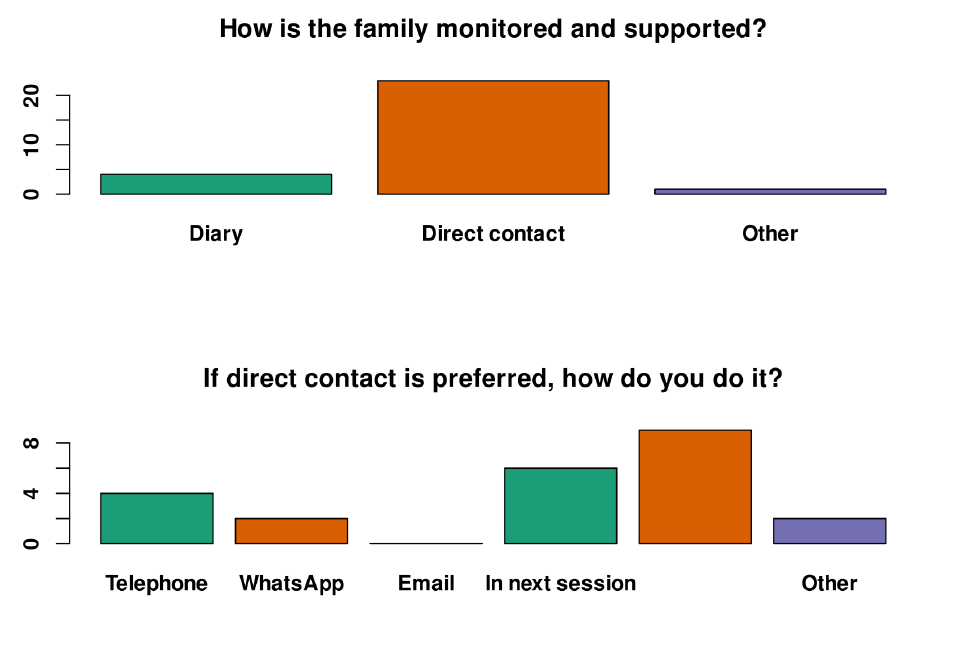
Figure 9. Monitoring and supporting the